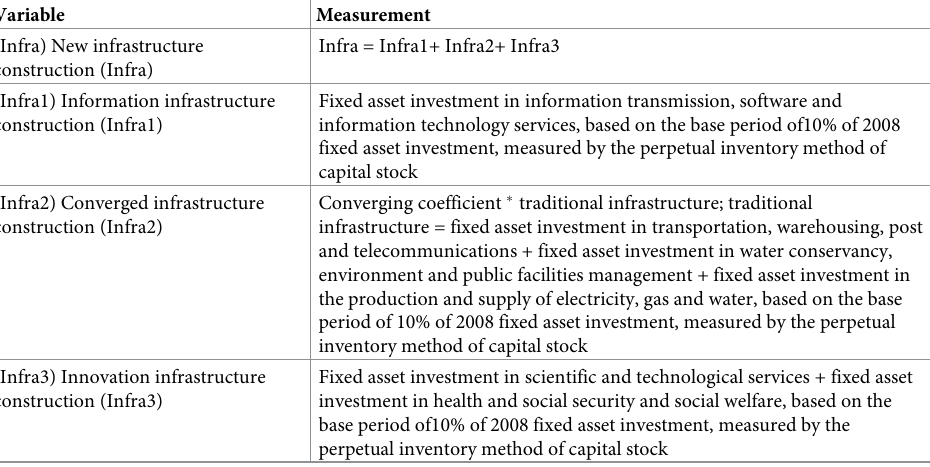
Table 1. Classification and measurement of new